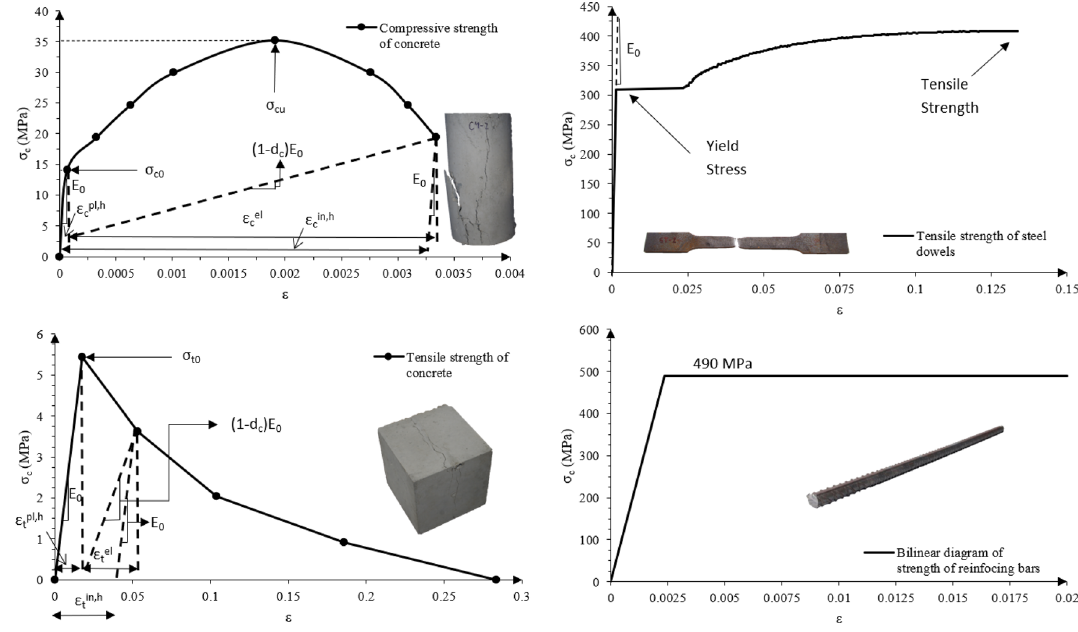
Figure 7. Material properties of steel and concrete.